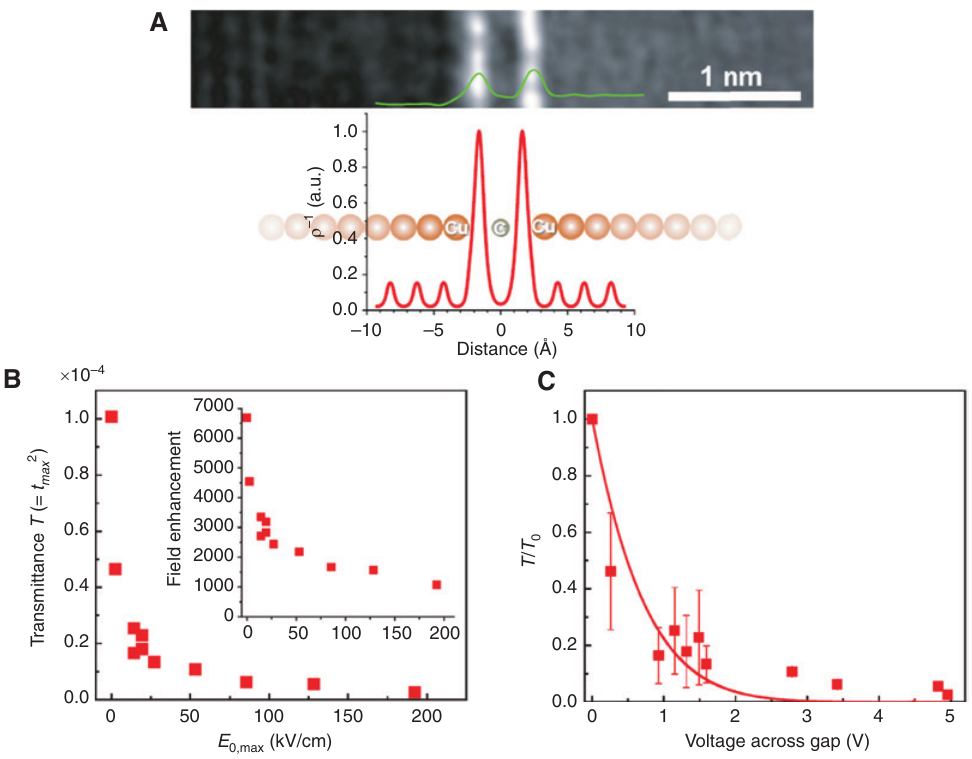
Figure 22: Nonlinearity in THz transmission through Angstrom-sized vDW gap. (A) Cross-sectional TEM image of Cu-SLG-Cu composite (top). The green curve is vertically averaged line profile of the composite. The red curve (middle) denotes the plane-averaged inverse valence electron charge density. (B) Maximum normalized transmittance with varying incident THz field E . Inset represents retrieved FE calculated by using the Kirchhoff method. (C) Measured (dots) and calculated (curve) 0 nonlinear optical response where T is the transmittance without nonlinear response. This figure is reproduced from Ref. 0